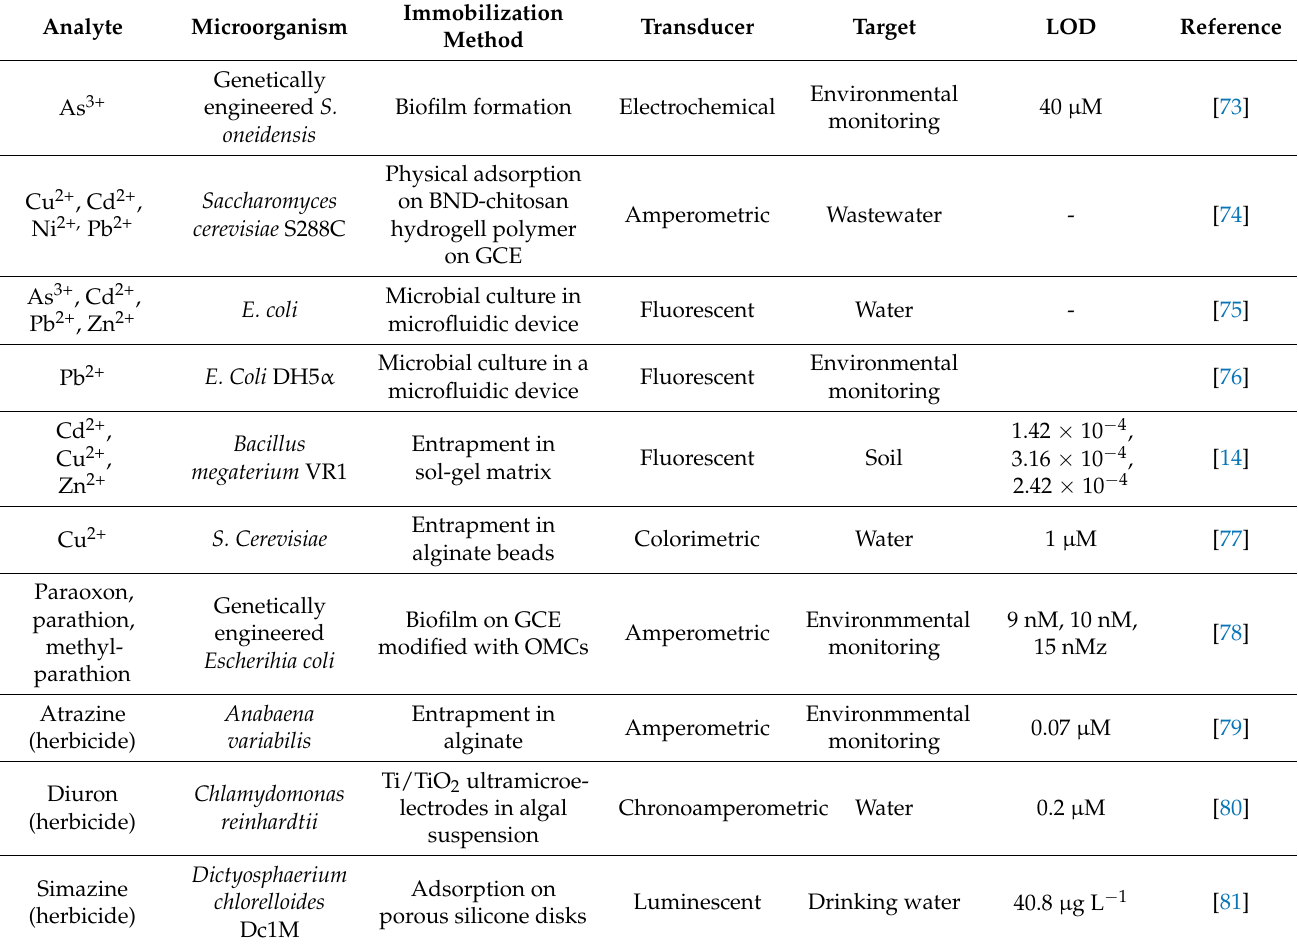
Table 3. Examples of microbial biosensors used for environmental